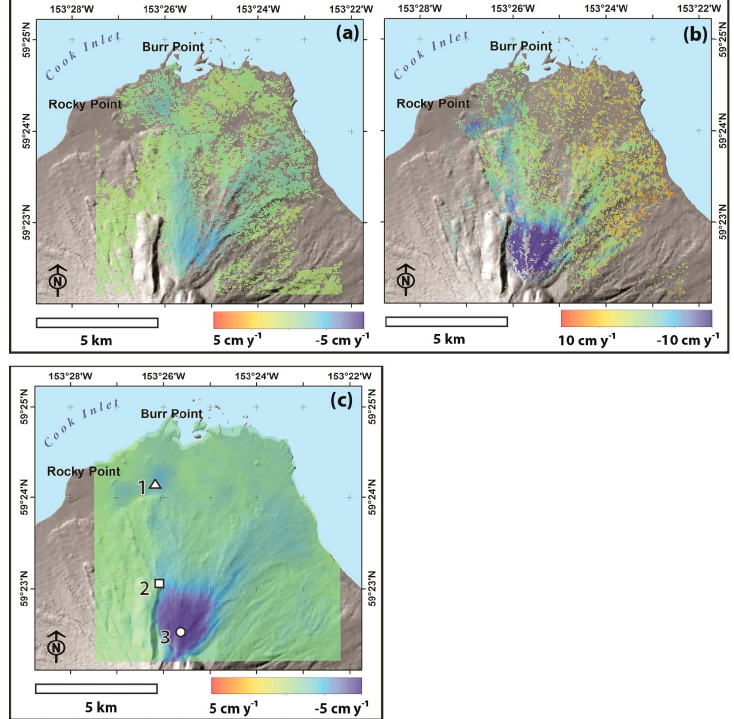
Figure 5. Average deformation rates ( Δ s) obtained by InSAR time-series analysis (cm·year − 1 ); deformation rates apply to ( a ) ERS-1/2 (June 1992 to October 2005); ( b ) Radarsat-1 (6 February–7 April); and ( c ) ALOS-PALSAR (July 2007 to October 2010). Locations labeled 1, 2, and 3 in ( c ) are data points whose deformation across each time series is plotted in Figure 6. Note that the deformation key shown for Radarsat-1 data in ( b ) is shown at a smaller scale than ( a ) or ( c ), to accommodate the higher subsidence that occurred immediately after the 2006 eruption.